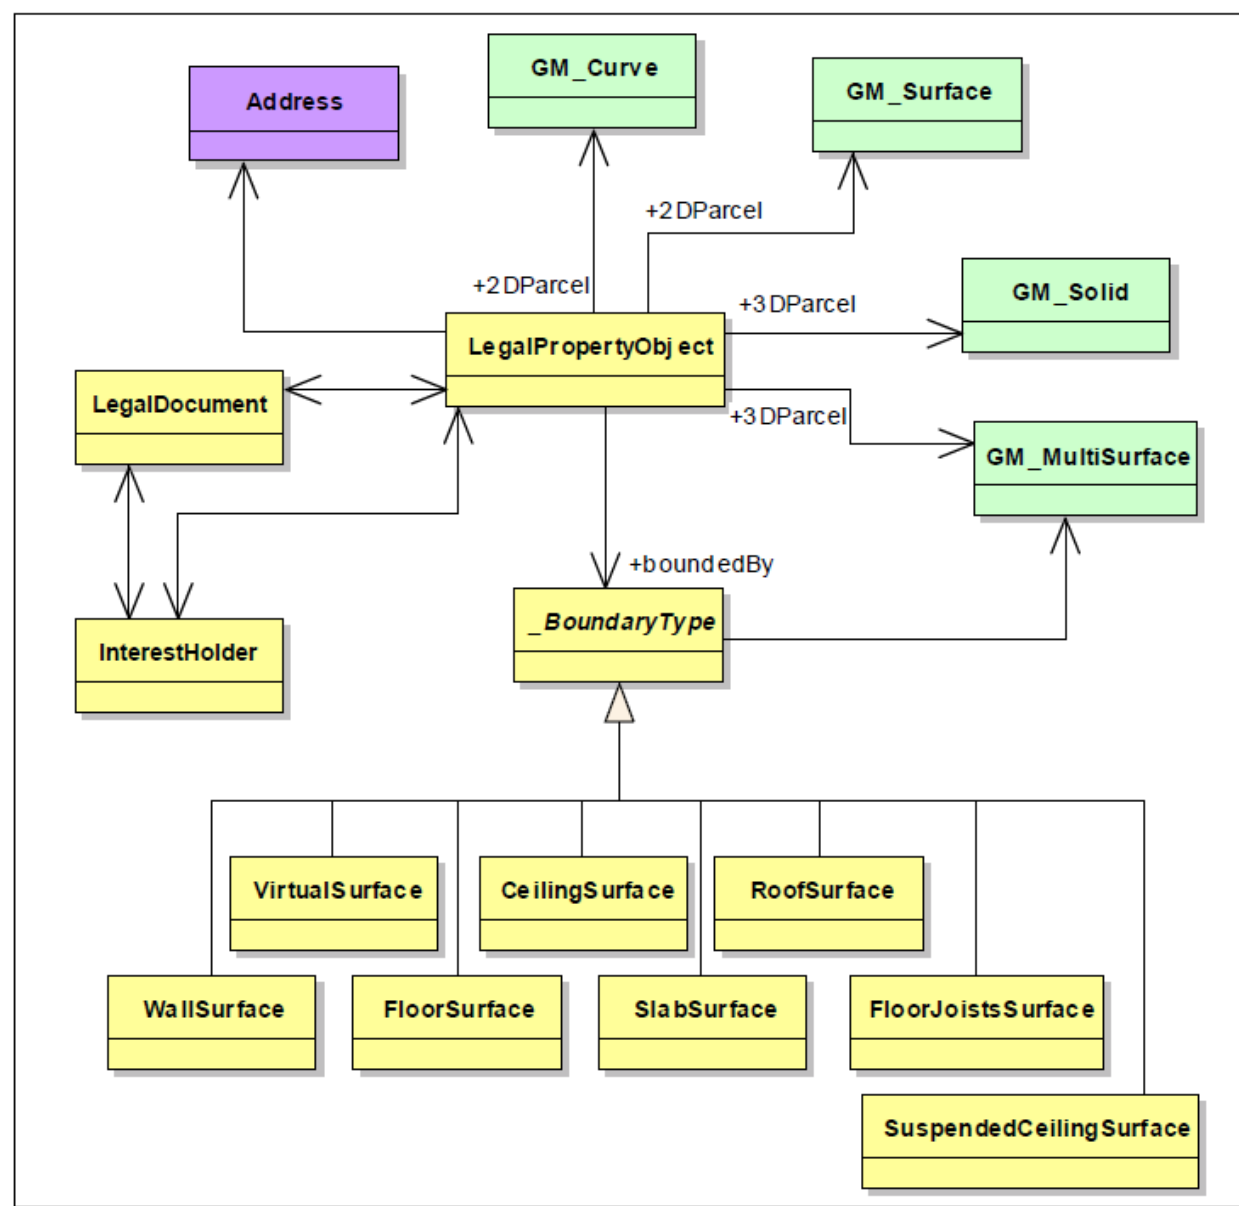
Figure 7. Spatially and semantically coherent conceptual model of the